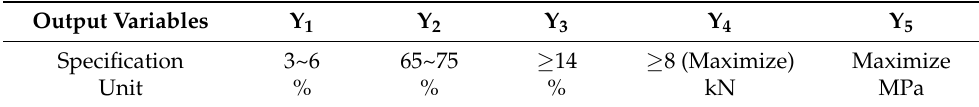
Table 8. Volumetric and physical property constrains of the output variables.